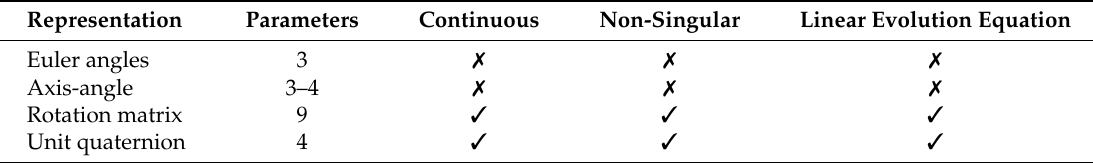
Table 1. Main characteristics of the most used parametrizations to represent an orientation. Representation Parameters Continuous Non-Singular Linear Evolution Equation Euler angles 3 Axis-angle 3–4 Rotation matrix Unit